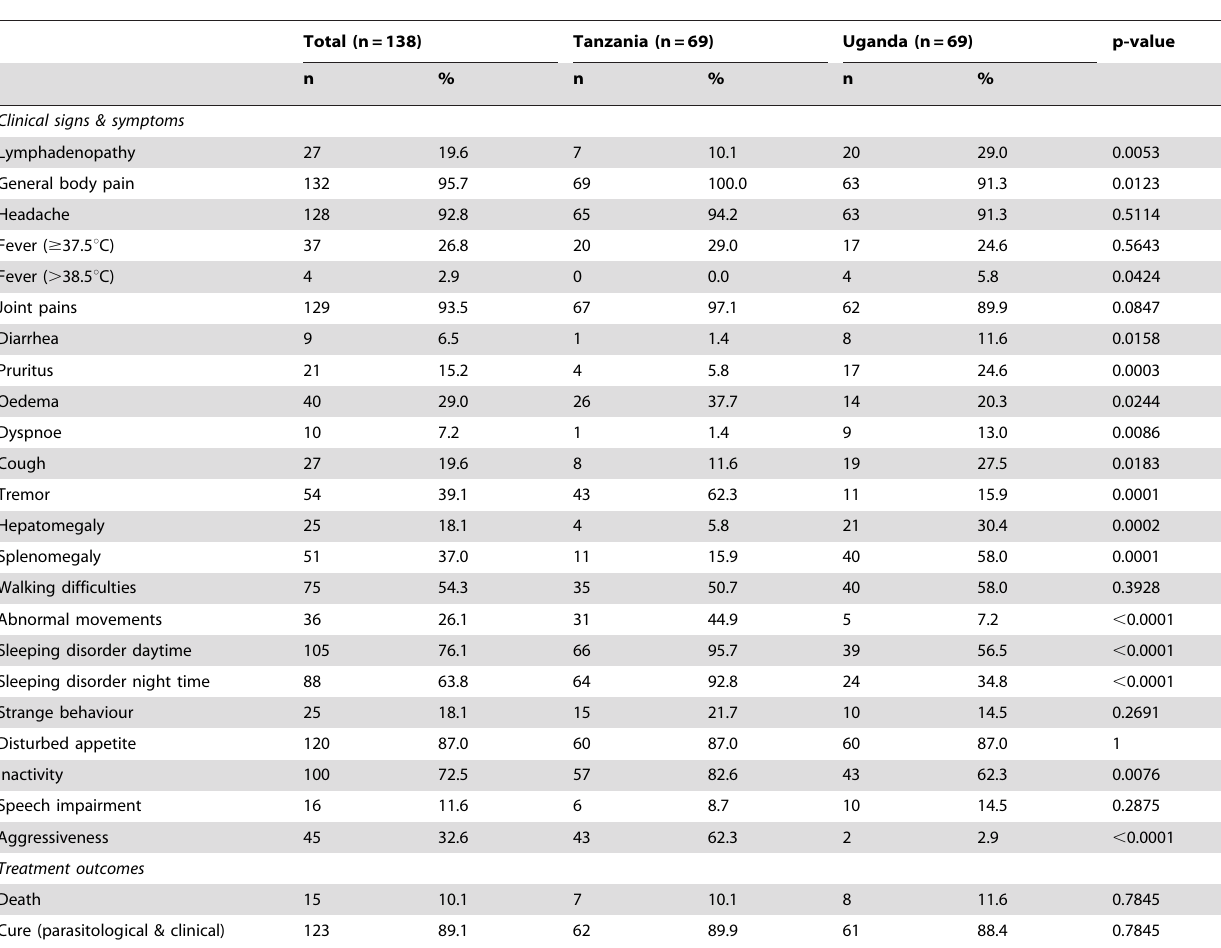
Table 3. Clinical signs and symptoms at baseline and treatment